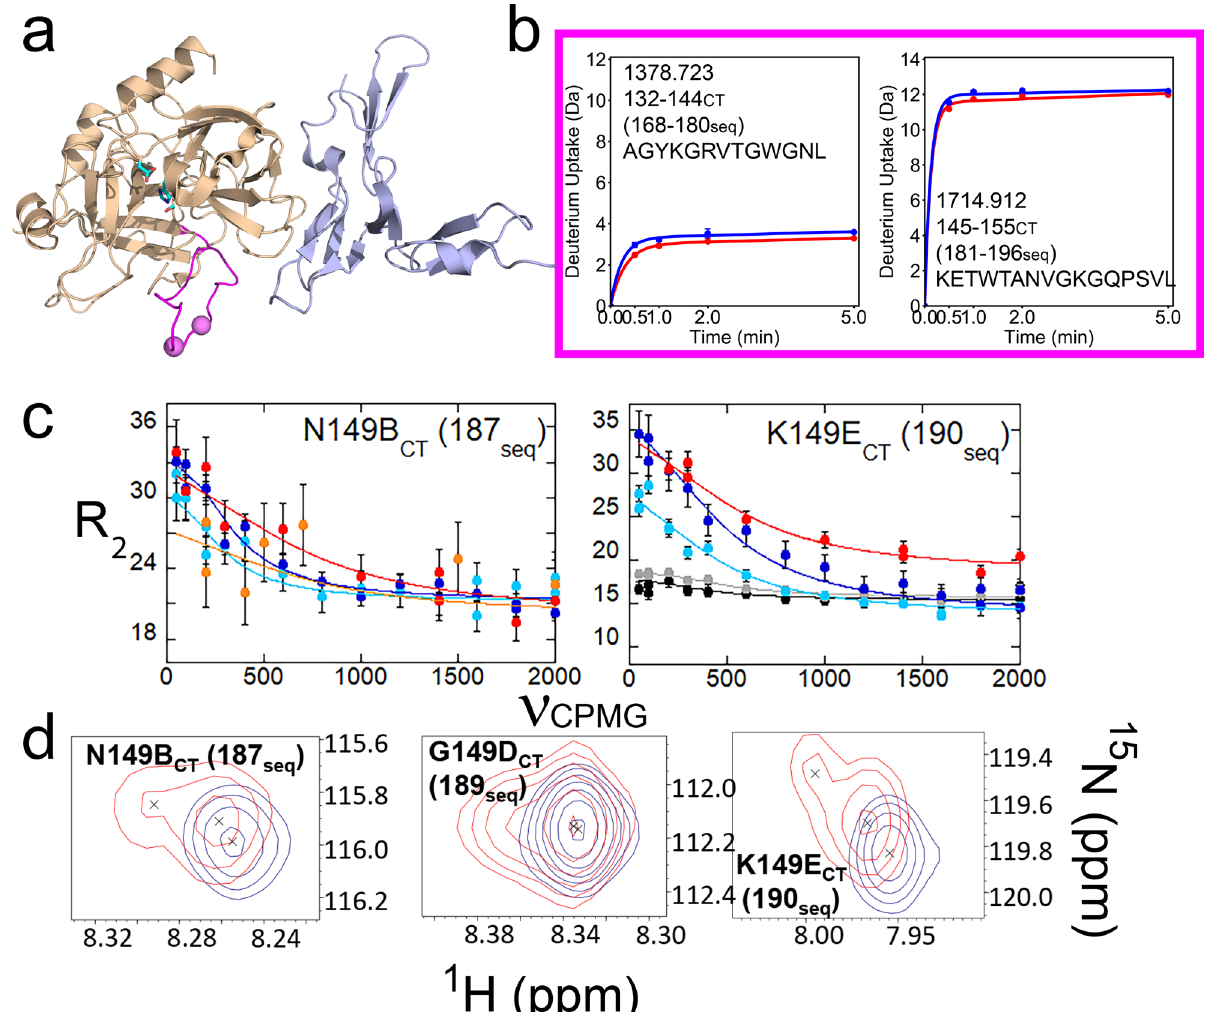
Figure 6. ( a ) Structure of thrombin (wheat) bound to TM456 (light blue) [PDB ID: 1DX5]. Residues 140-155 CT (176-196seq) of the 140s CT loop are colored magenta. The amides of residues corresponding to resonances experiencing μs-ms dynamics in both thrombin-TM456 and apo-thrombin are shown as violet spheres. Sidechains are shown for the catalytic triad (cyan). ( b ) Deuterium uptake plots for the peptides spanning residues 132-144 CT (168-180seq; MH + 1378.723) and 145-155 CT (181-196seq; MH + 1714.912). The colors are the same as in previous figures. ( c ) CPMG plots for thrombin resonances corresponding to residues Asn 149B CT (187seq) and Lys 149E CT (190seq). The colors of the curves are the same as in previous figures. CPMG data could not be obtained from the 600 MHz spectra for Thr 149 CT (187seq). ( d ) Examples of thrombin-TM456 HSQC (red) doublet resonances compared to apo-thrombin (blue) resonances for residues in the 140s CT